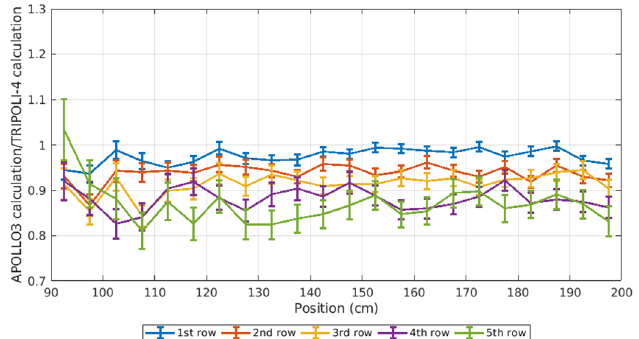
Fig. 29. Comparison between APOLLO3 ® and TRIPOLI-4 ® codes on the production of tritium